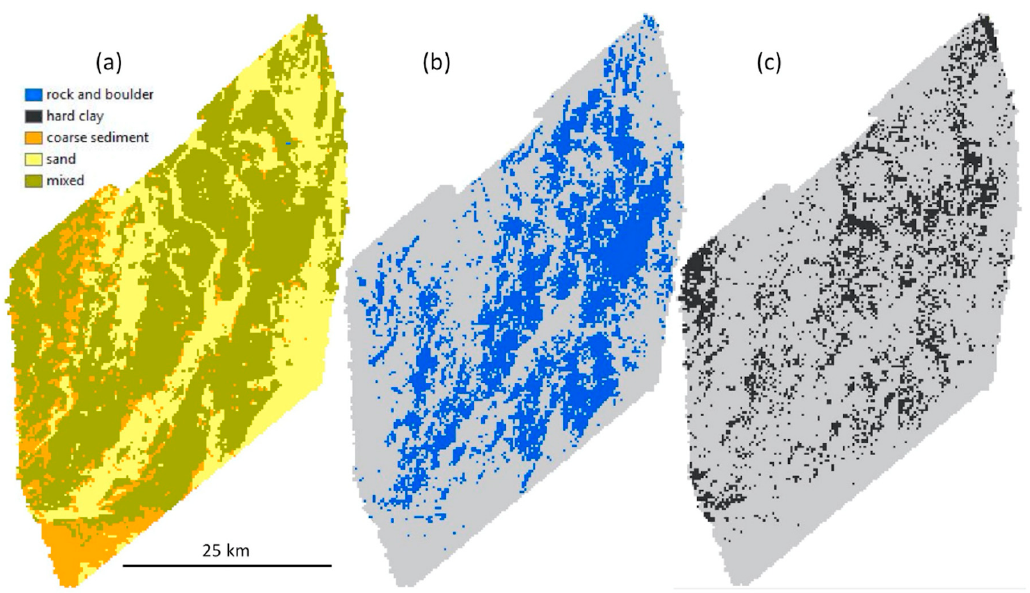
Figure 15. ( a ) HUB 3 substrate map at the 250 m scale, ( b ) 250 m pixels that contain HUB 3 rock and boulder class (blue) at the 5-m scale, ( c ) 250 m pixels that contain HUB 3 hard clay class (black) at the 5-m scale.